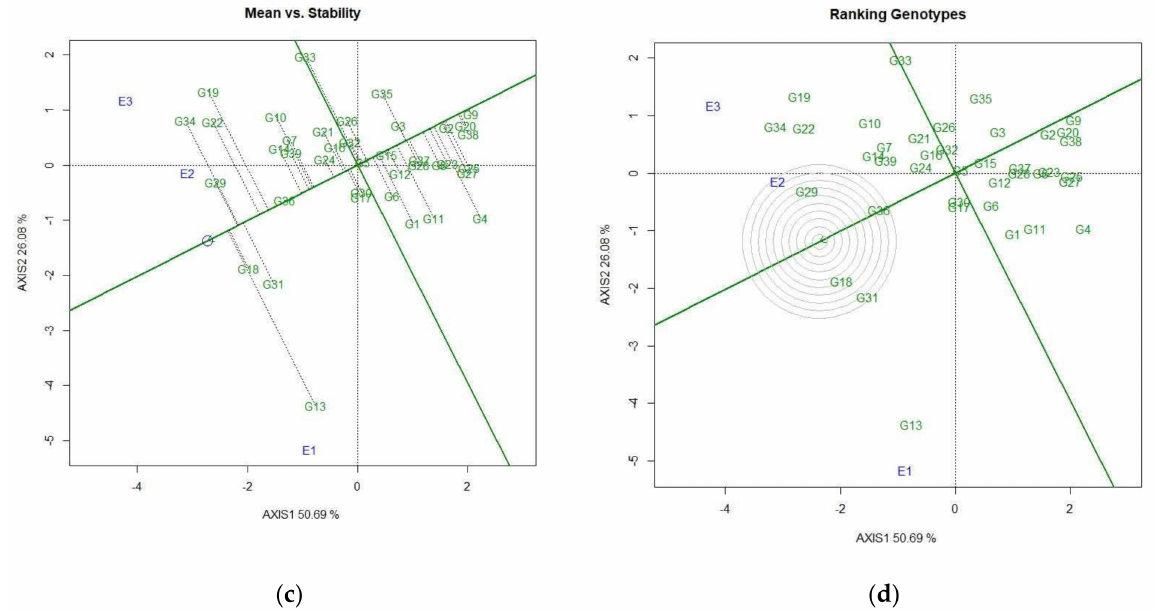
Figure 6. GGE biplot view: ( a ) polygon view delineating successful genotypes in each environment; ( b ) discriminating and representative ability of the environment for grain yield; ( c ) AEC view showing the relationship between grain yield and stability for identification of stable genotypes; ( d ) discovering ideal genotypes by ranking